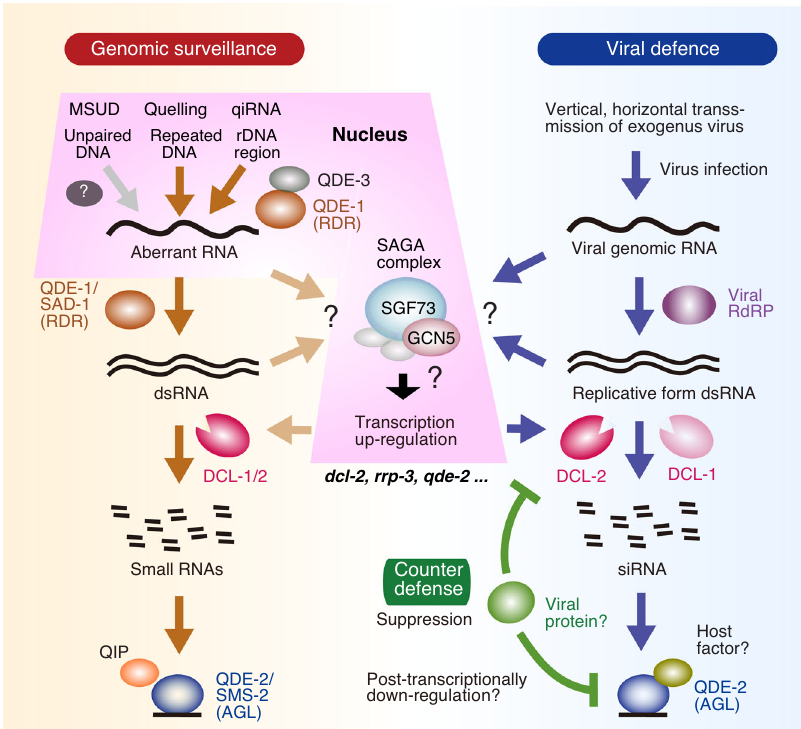
Fig. 6 Model of antiviral RNAi and overall effects of virus infection on Neurospora crassa . Proposed model of the antiviral RNAi pathway in parallel to the established transgene vegetative mitotic (quelling and qiRNA) and meiotic silencing by unpaired DNA (MSUD) pathways for genomic surveillance. The meiotic and mitotic RNAi pathway was modi fi ed from Chang et al. 34 . The major players in RNAi, RNA-dependent RNA polymerase (RdRP), or RDR (QDE-1, SAD-1), Dicer (DCL-1, DCL-2), and Argonaute (SMS-2, QDE-2), are shown in the pathways. Key players, DCL-1, DCL-2, and QDE-2 are shared by the antiviral and meiotic/mitotic pathways. As a counterdefense, viruses such as NcFV1 appear to deploy RNAi suppressors that post-transcriptionally downregulate RNAi key genes (see Fig. 5d). It remains unknown whether antiviral RNAi genes of N. crassa are transcriptionally repressed by viruses or whether the SAGA ( S pt – A da – G cn5 acetyltransferase) complex and Dicer transcriptionally upregulate many N. crassa genes, as in the case for other fi lamentous ascomycetes, such as Cryphonectria parasitica